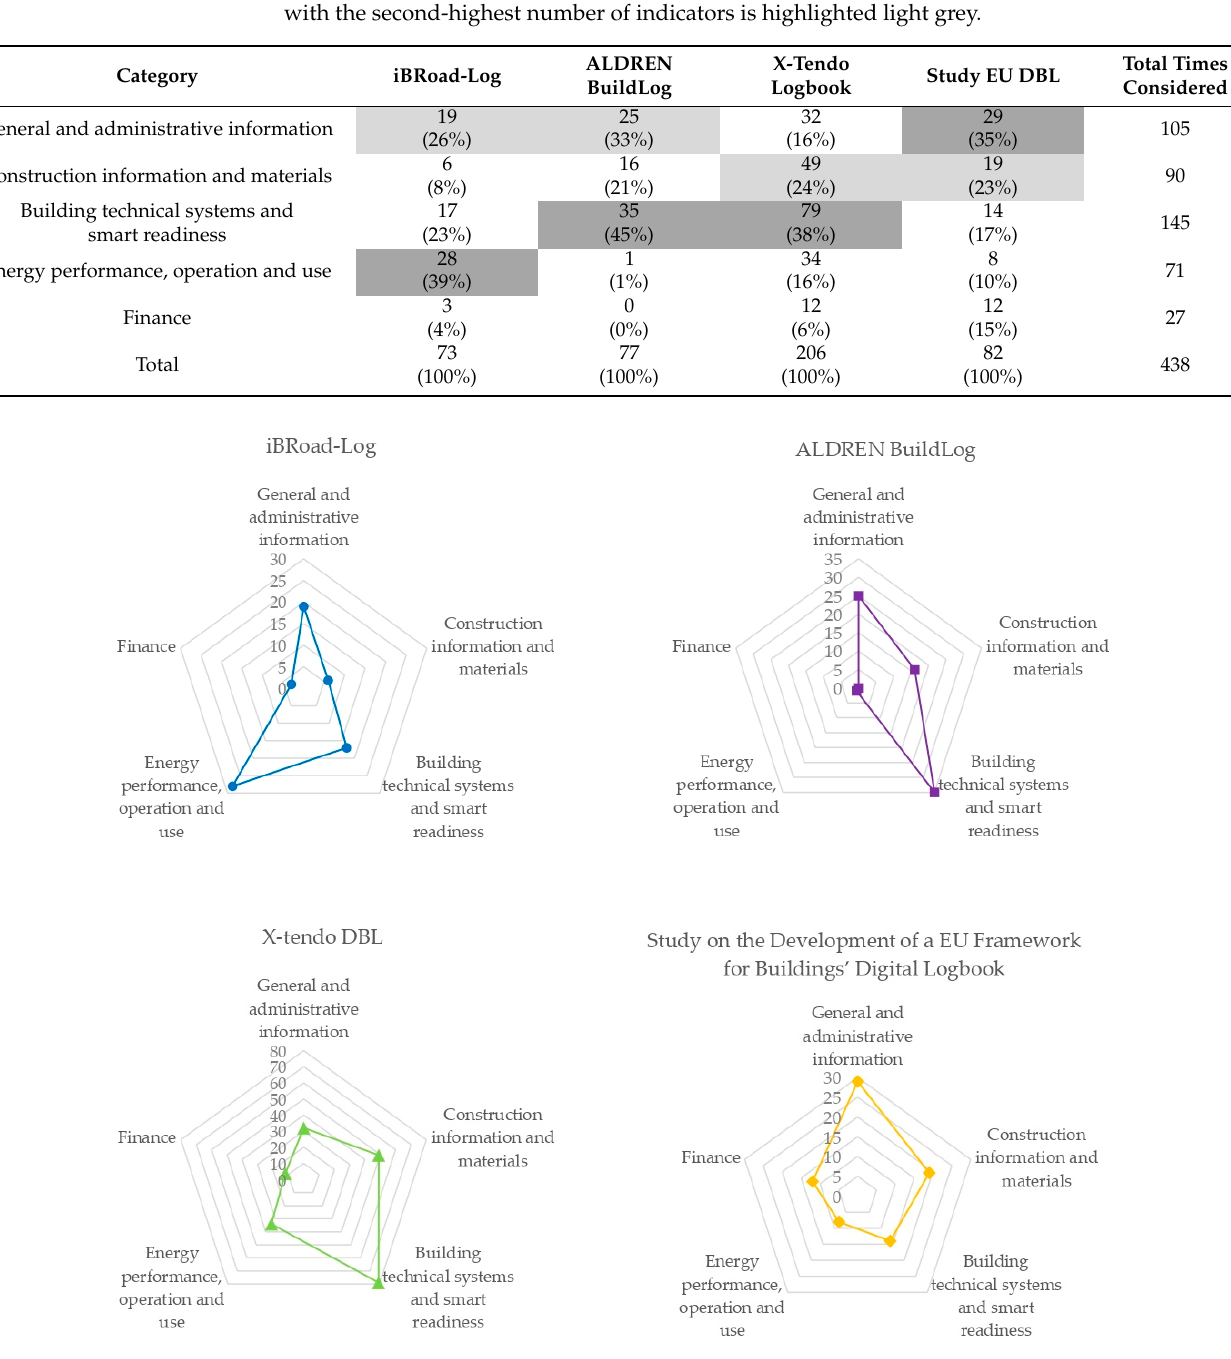
Table 6. Number of indicators of each category and percentage they represent in each model. The category with the highest number of indicators in each model is highlighted dark grey. The category with the second-highest number of indicators is highlighted light grey.